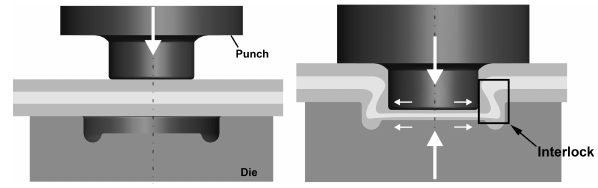
Figure 1: Principle of three steel sheets joining.